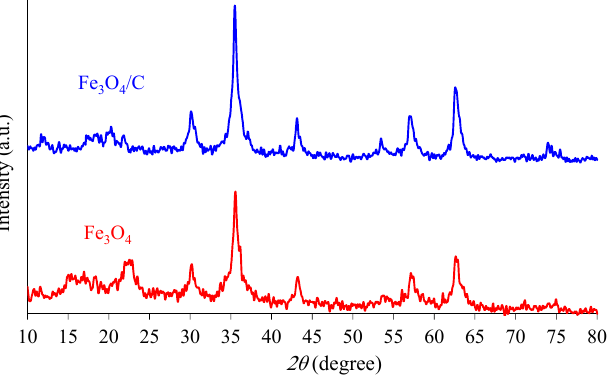
Fig. 5: XRD patterns of Fe